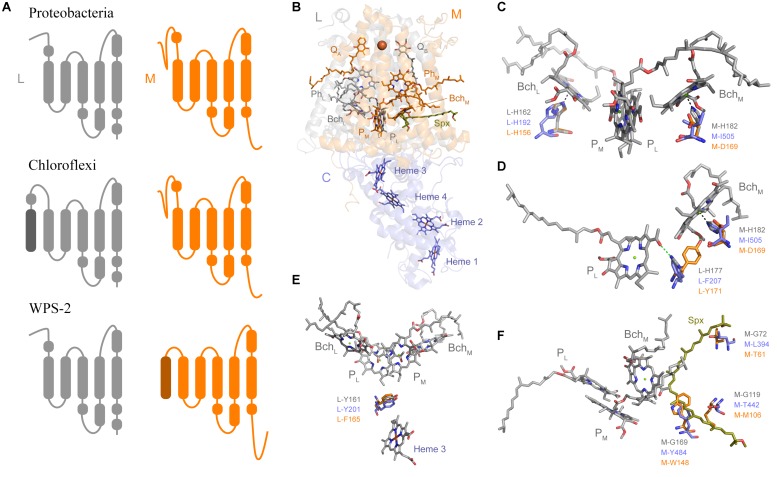
Structural comparisons of Type II reaction centers. (A) Schematic representation of the transmembrane helices. (B) The crystal structure of the PbRC from Thermochromatium tepidum highlighting all redox cofactors. (C) Comparison of the ligands to BchL and BchM. Residues in gray are those from the PbRC, in blue those from the Cryo-EM structure of Roseiflexus castenholzii, and in orange those from the homology model of the WPS-2 reaction center proteins. (D) Changes around hydrogen-bonding partners to PL. (E) Changes around L-Y161, a residue important for electron transfer from the tetraheme cytochrome into the oxidized photochemical pigments. (F) Changes around the carotenoid-binding site. Spx denotes spirilloxanthin.